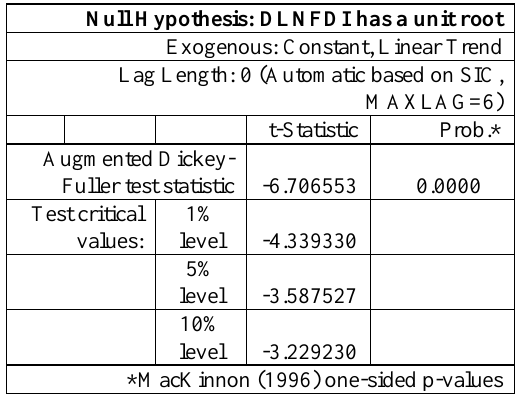
Table 2: ADF Test for FDI